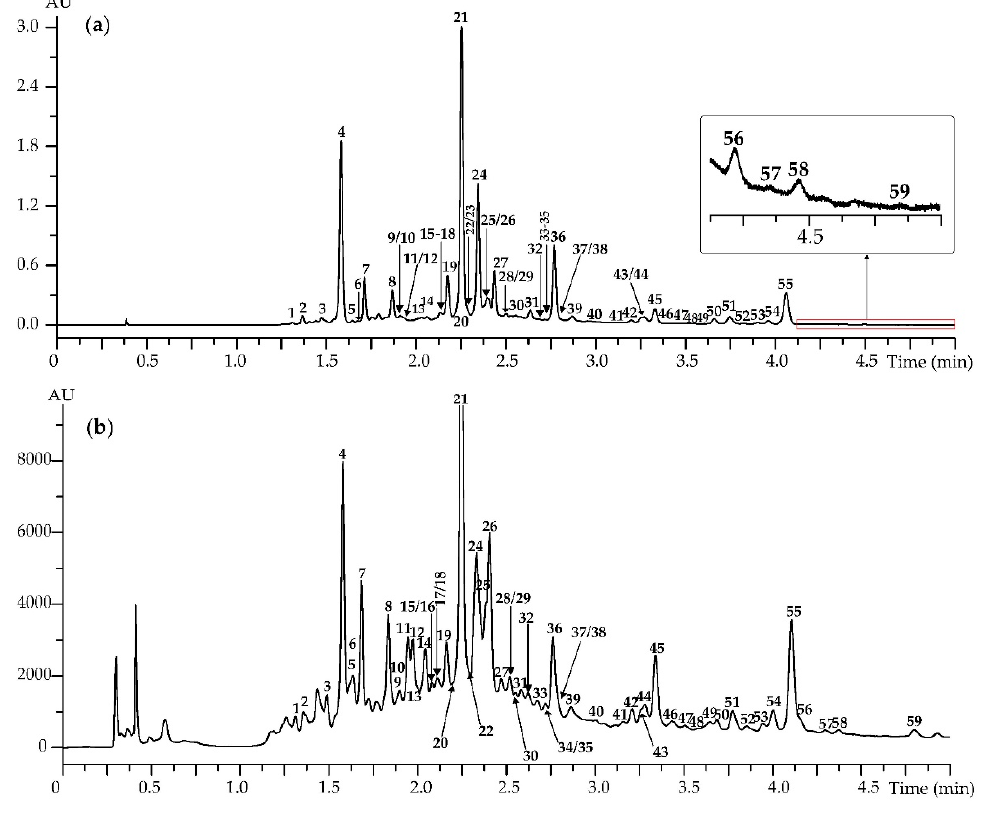
Figure 2. High-Performance Liquid Chromatography with ( a ) Diode Array Detection (HPLC-DAD) chromatogram (330 nm; on cut—enlarged fragment) and ( b ) High-Performance Liquid Chromatography with Electrospray Ionization Triple Quadrupole Mass Spectrometric Detection (HPLC-ESI-QQQ-MS) chromatogram (base peak chromatogram or BPC mode, negative ionization) of A. frigida herbal extract. Compounds are numbered as listed in Table 2. Chromatographic ( t R ), ultraviolet data (UV), collision energy (CE) and mass-spectrometric